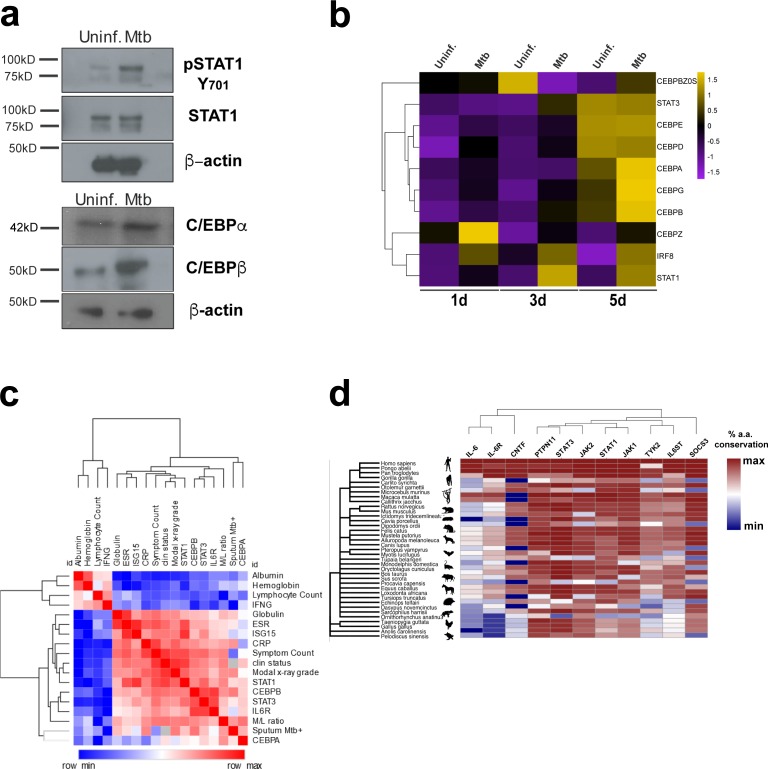
Gene expression and protein conservation of the IFN/IL6/CEBP gene module and correlation analysis to TB disease.(a) Western blotting for pSTAT1 (Y701), total STAT1, C/EBPα, C/EBPβ and actin from uninfected or Mtb-infected CD34+ cells for 5 days as described in the materials and methods. (b) Heat maps showing z-score values of CEBP family members and e ISGs expressed by CD34+ cells exposed to Mtb (MOI3) at different time points. (c) Cluster dendrogram and heatmap of Spearman correlation coefficients between molecular and clinical data from a UK cohort of patients with latent and active TB (Berry et al., 2010) (n = 30, raw data were obtained from GXB, sputum smear only available for active TB patients). (d) Heat map showing IL6 network generated by STRING co-occurrence protein conservation scores across primates, mammals, birds and reptiles. Note highly conserved STAT1/STAT3 and other molecules found in the network (depicted in Figure 6a, STRING) throughout primate and mammalian evolution.